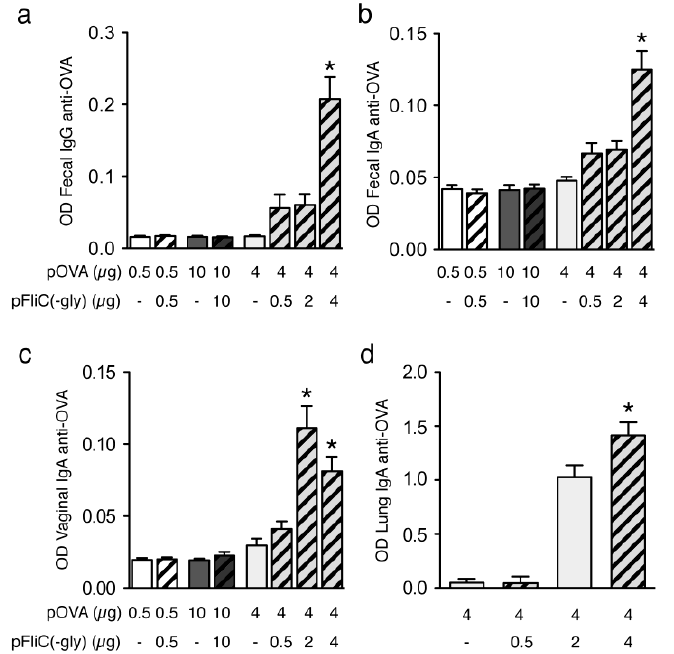
relative to pOVA immunizations without pFliC(-gly) defined as p ≤ 0.05 were considered significant using a two-tailed unpaired Student t